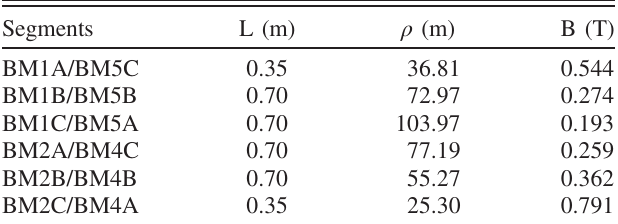
TABLE II. Detailed parameters of LGBs for SPring-8-II. Each LGB is composed of three segments, named A, B, and C (interim).